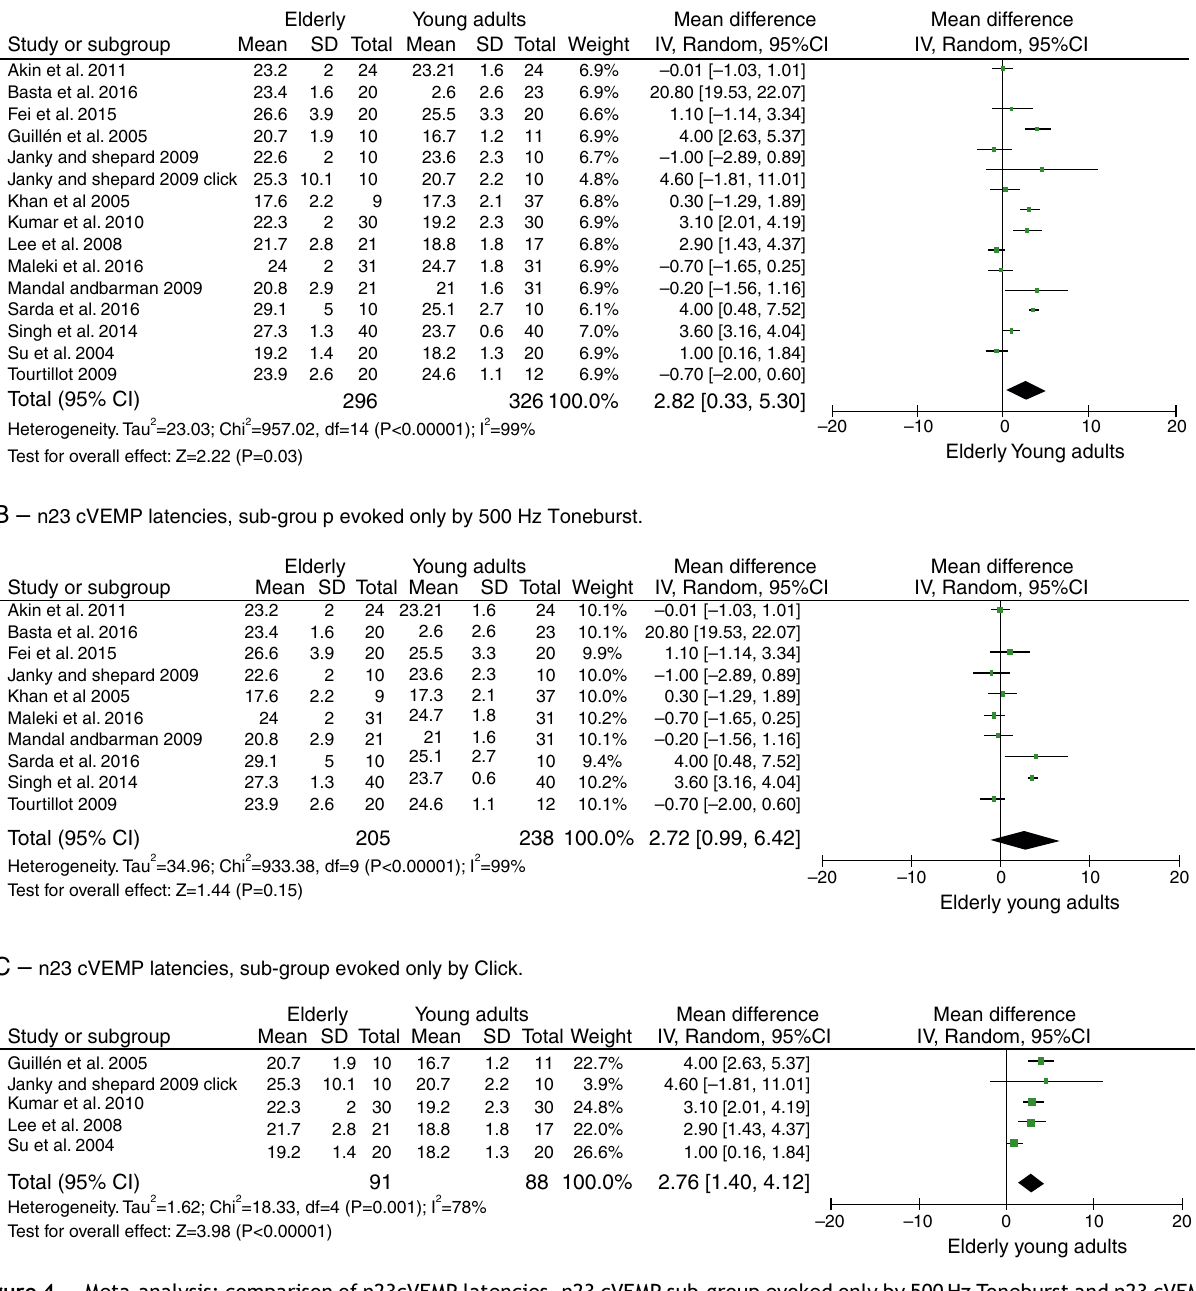
Figure 4 Meta-analysis: comparison of n23cVEMP latencies, n23 cVEMP sub-group evoked only by 500 Hz Toneburst and n23 cVEMP sub-group evoked only by Click. (A) n23 cVEMP latencies. (B) n23 cVEMP latencies, sub-group evoked only by 500 Hz Toneburst. (C) n23 cVEMP latencies, sub-group evoked only by